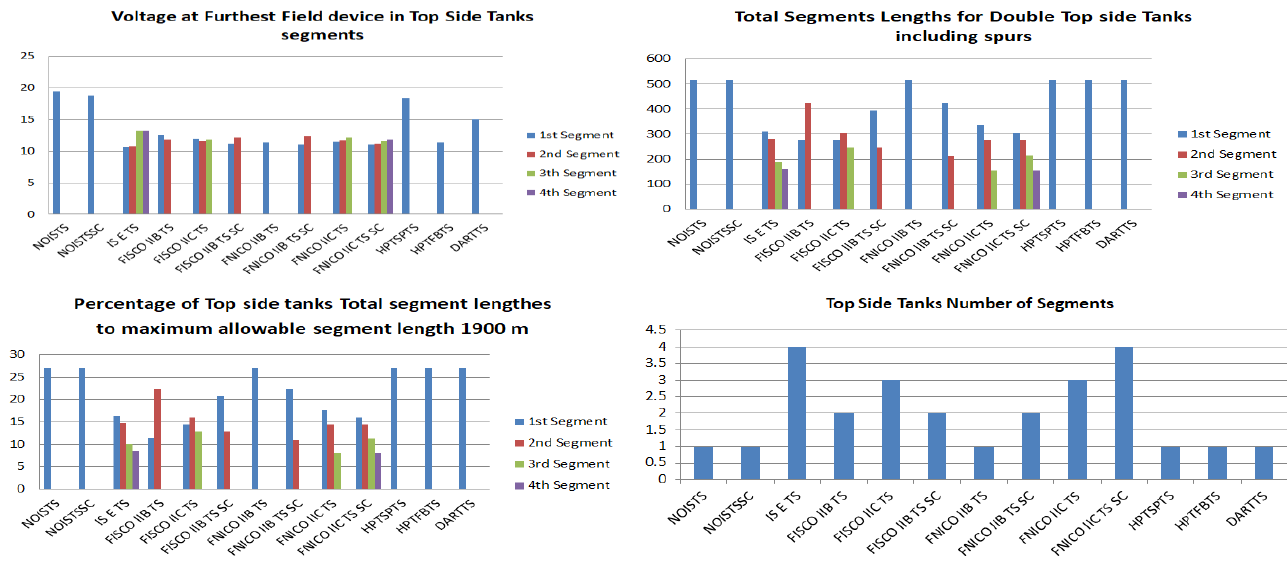
Figure 12. Illustration of voltage at farthest field devices, total segments’ lengths and percentage of them to the maximum allowable length of 1900 m and total number of segments for top side tanks’ sub-models.